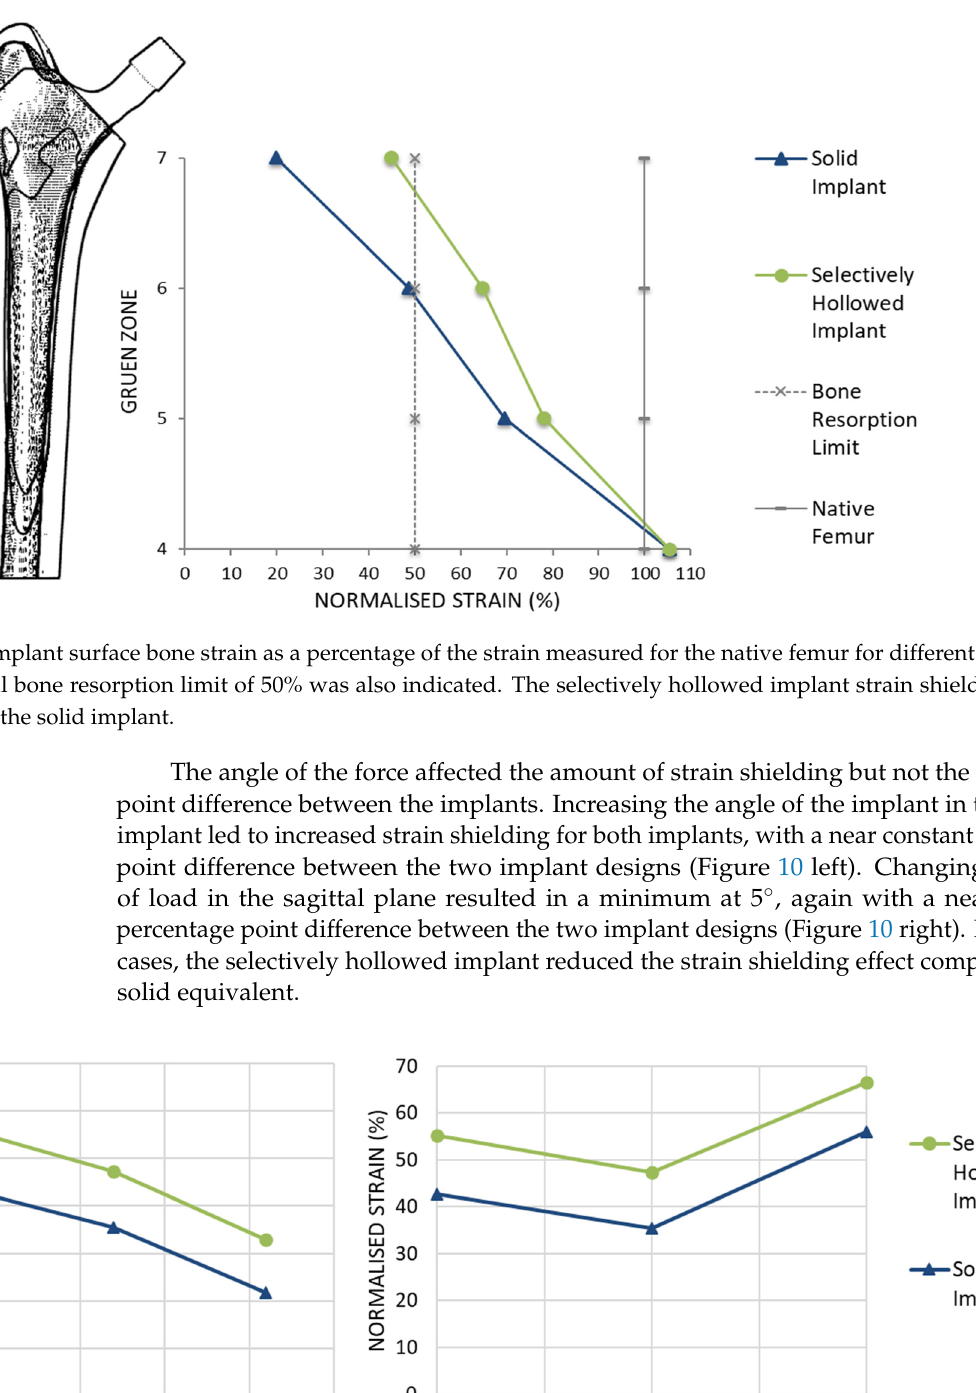
Table 3. Maximum surface bone strain and percentage of native bone strain for the selectively hollowed, solid implant and native femur for peak gait loading.